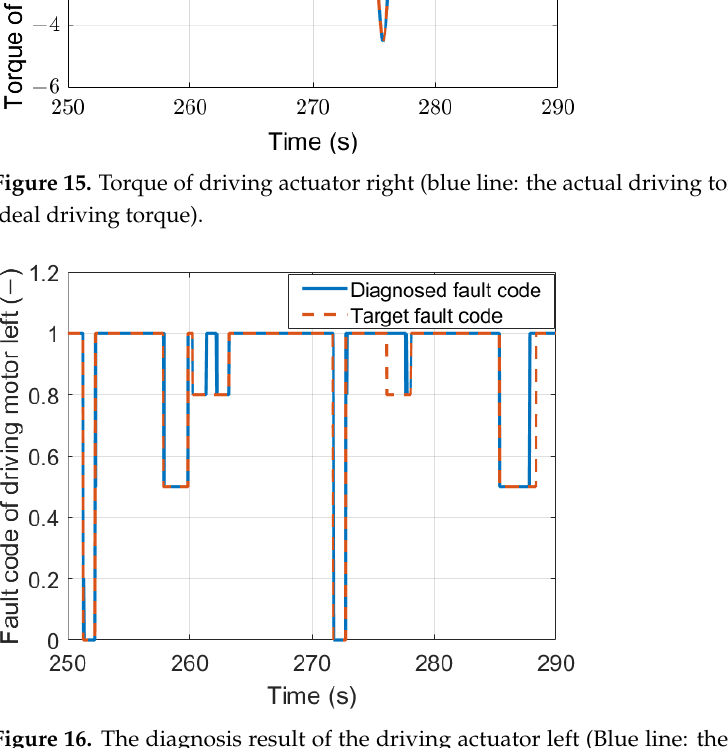
Figure 16. The diagnosis result of the driving actuator left (Blue line: the actual diagnosis results, which presented six faulty states; red dotted line: the original fault label).